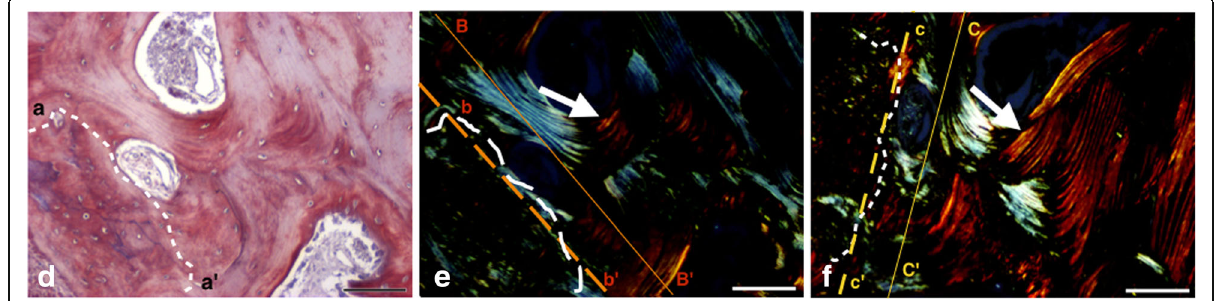
Fig. 5 Histomicrograph of a biopsy from the BC +EMD group, showing an aspect of newly formed bone. Section stained with picrosirius-hematoxylin and digitalized with bright-field ( d ) and linearly polarized light ( e and f ). e , f Results of near 45° section rotation (between axes B – B ’ and C – C ’ ) to compensate some of the orientation-related effects associated with linearly polarized light. In d , typical Haversian systems are showed (area observed above dotted line , a to a ’ ). In e and f , the arrows indicate thin birefringents (appears visually as brilliance) collagen arrangement around Haversian canals suggestive of lamellar mature bone. Areas observed below dotted lines are suggestive of immature (non-lamellar) bone where collagen fiber undulations can be observed. The dark area corresponds to complete disorganization of the collagen fibers. Bar =100 μ